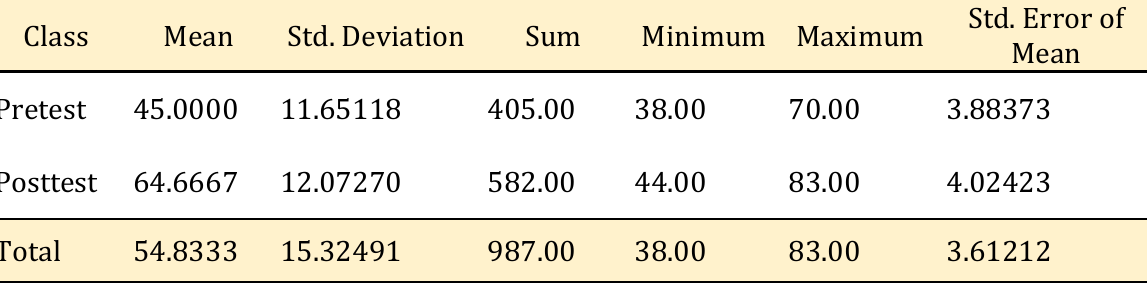
Table 2. The mean score and standard deviation of teenagers pre-test and post-test in this